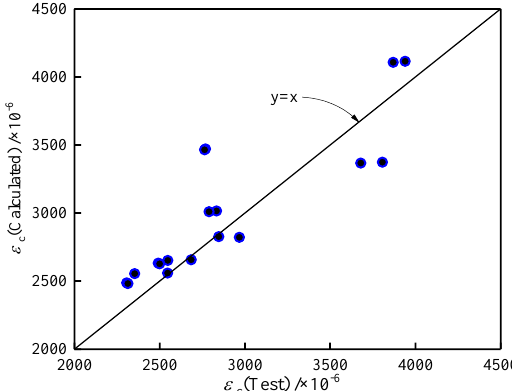
Figure 8. Comparison of ε c between experimental and calculated values.